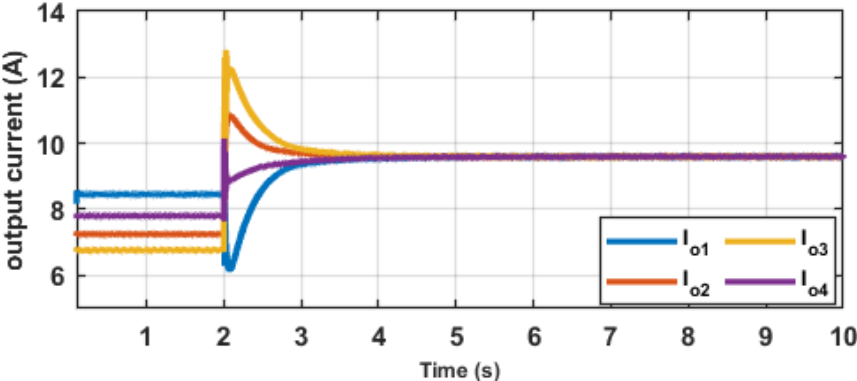
Figure 8. Output currents of DGs using Topology A.